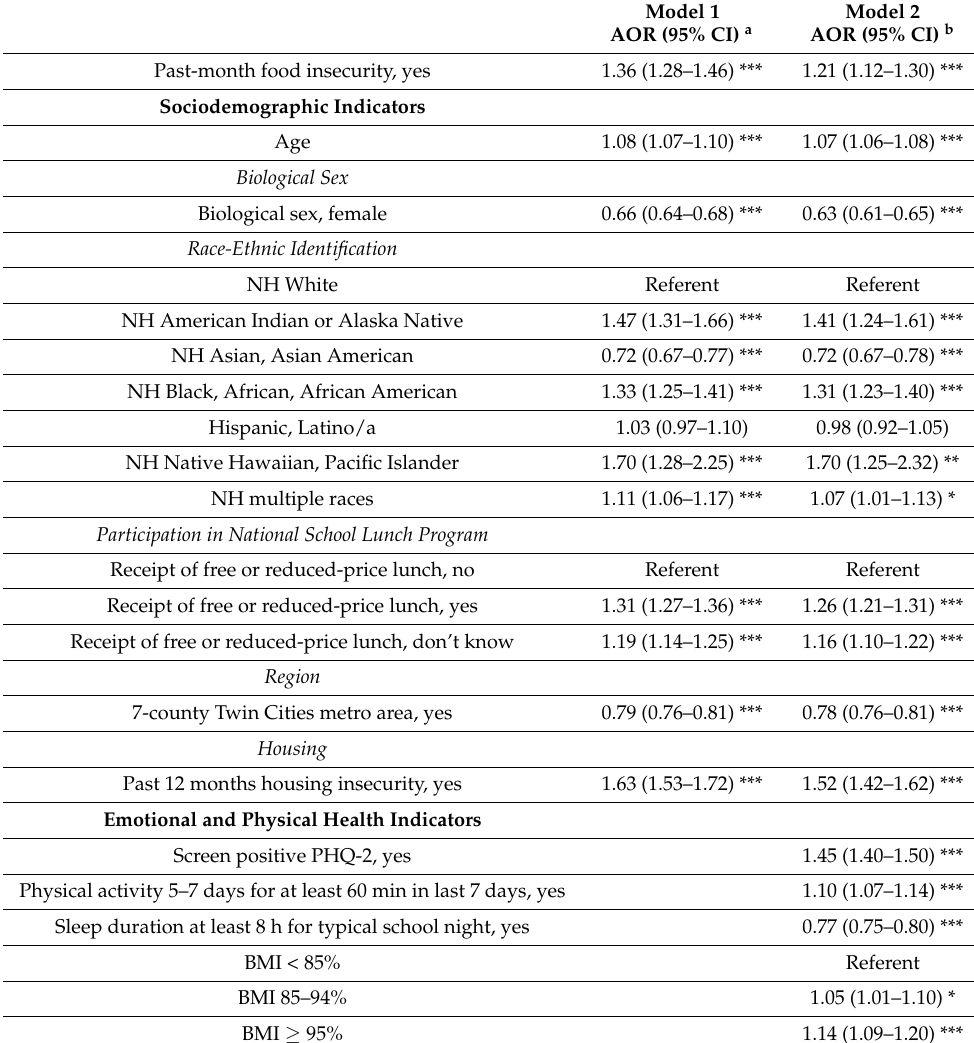
Table 4. Past-Month Food Insecurity and Student Consumption of Sugar-Sweetened Beverage One or More Times/Day, Past 7